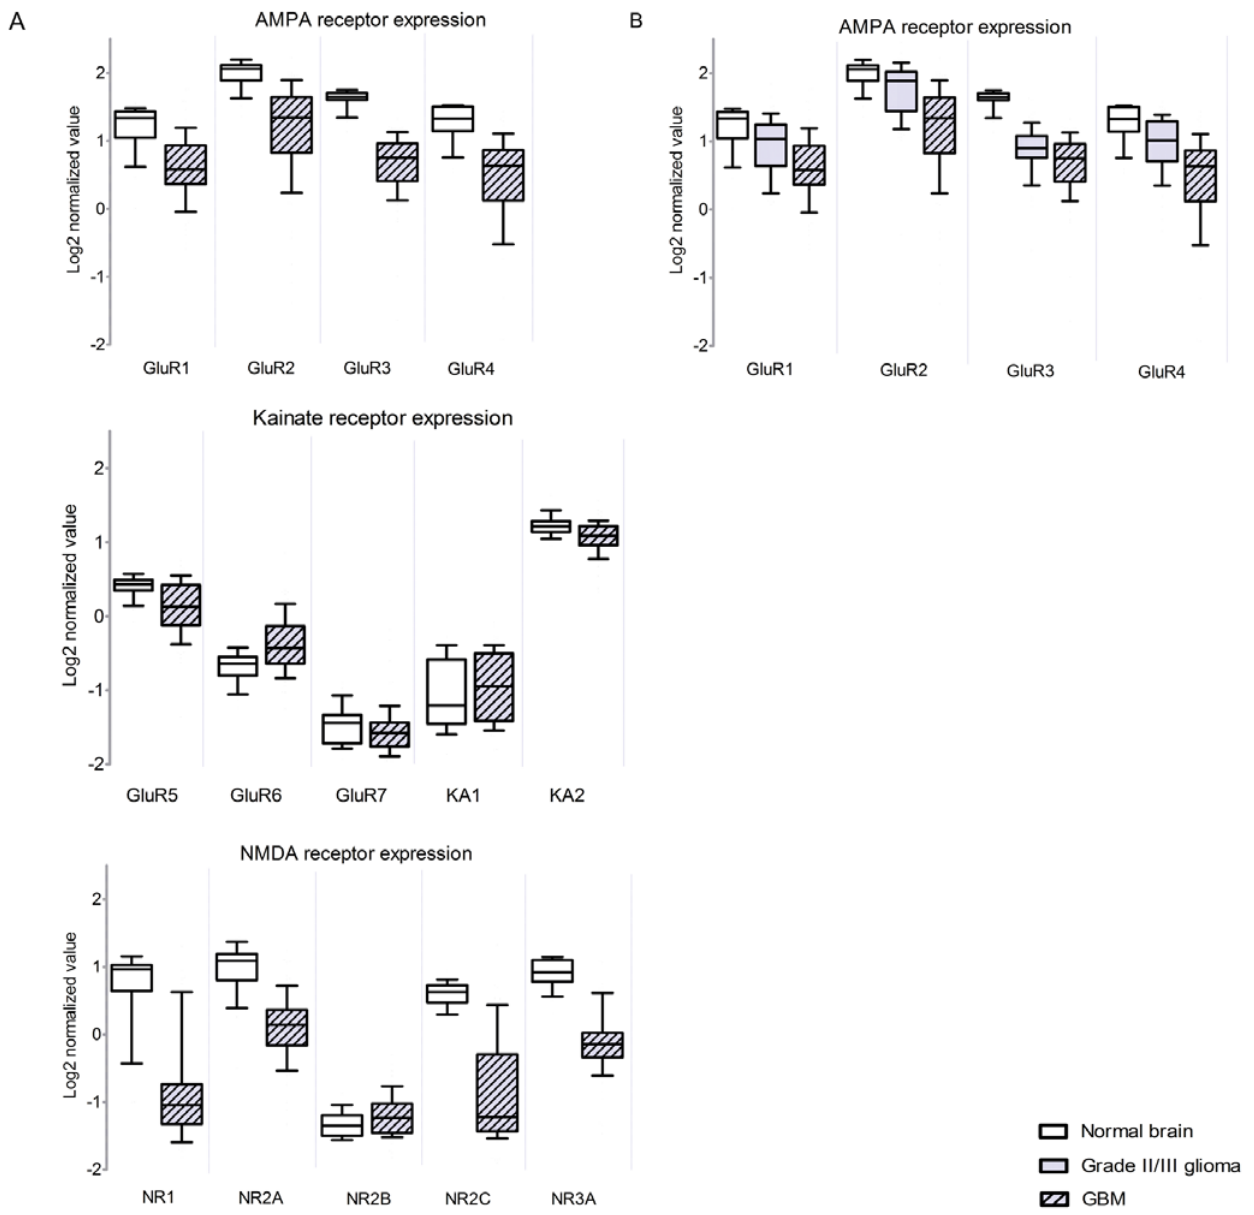
Figure 1. Insilico analysis of ionotropic glutamate receptor expression levels in GBM tumors. (A) Boxplots of expression of ionotropic glutamate receptors in a dataset of 77 glioblastomas (grey dashed), compared to normal brain from epilepsy surgery (white). p-values and t -test values shown in Table S1. (B) Compared to normal brain (white), low grade astrocytoma and oligodendroglioma (n=76, grey), AMPA receptor (GRIA1–4) expression is decreased in GBM (n=77, grey dashed) (p , 0.0001). Error bars indicate the standard deviation.